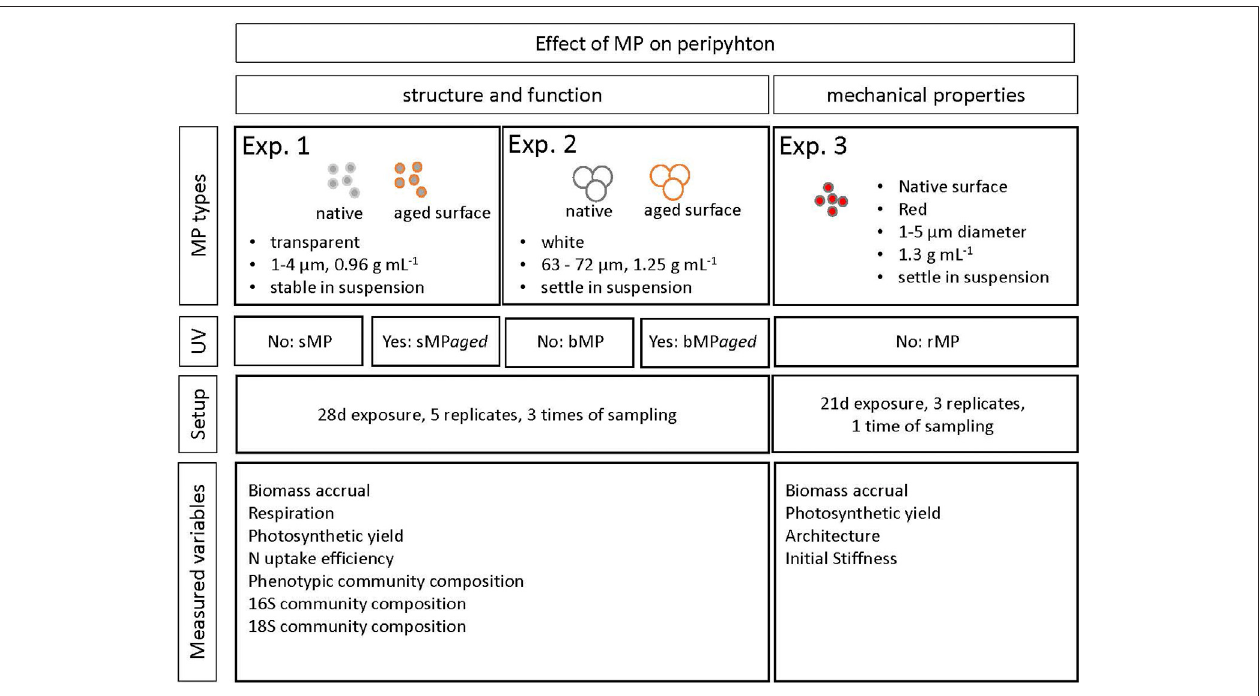
FIGURE 1 | Overview of the study design, including indication on MP characteristics used in each experiment and measured variables.